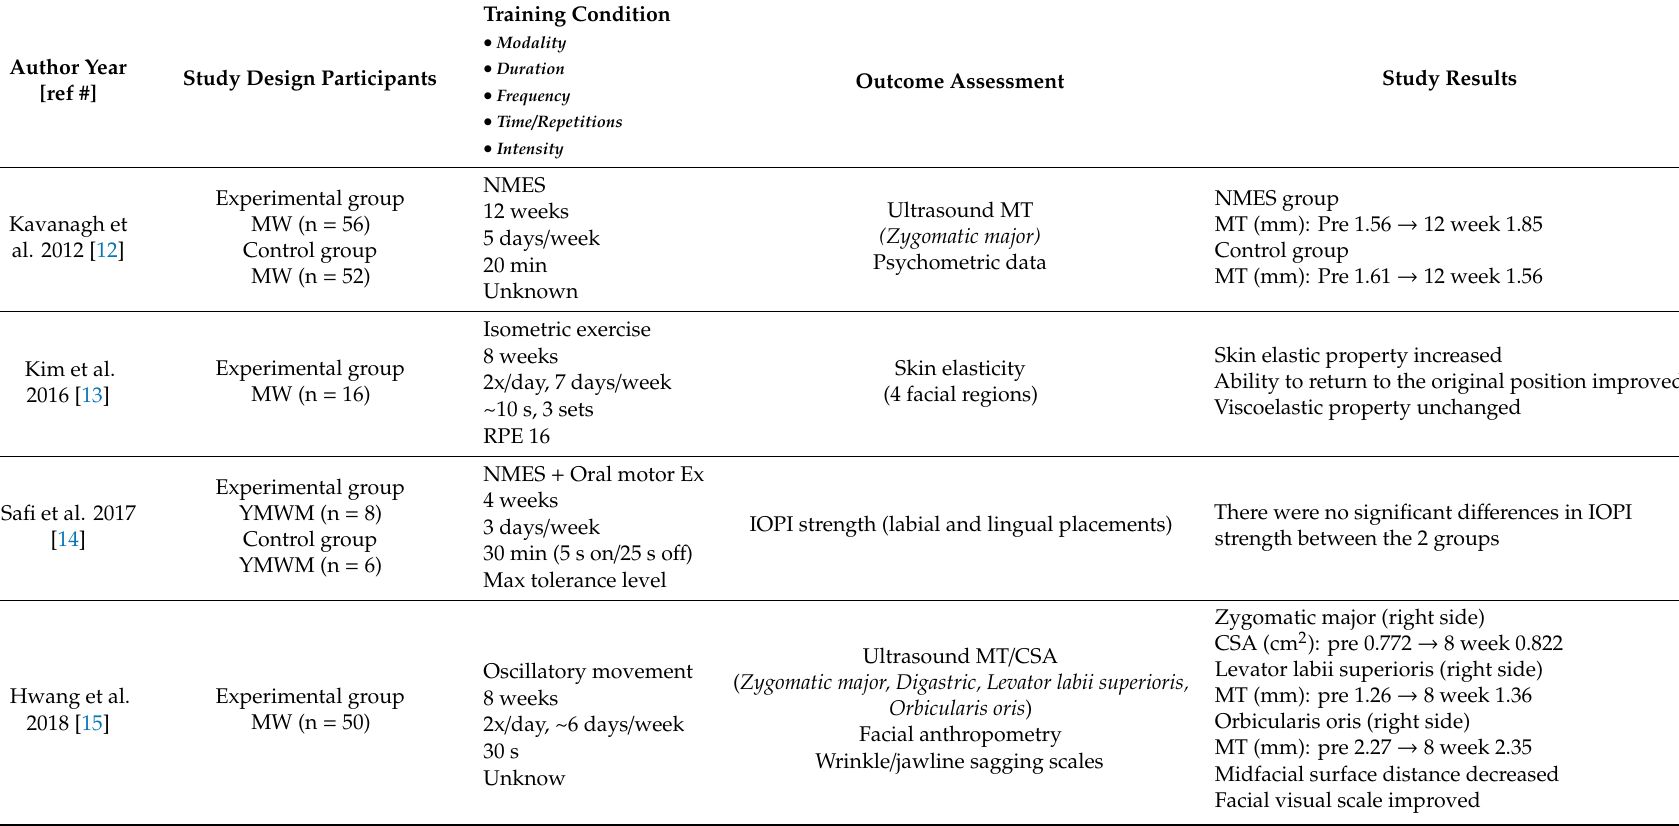
Table 2. Research results of studies included in this